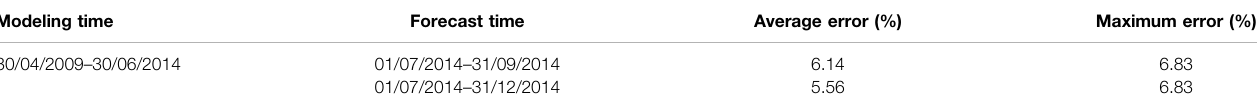
TABLE 10 | Slope stability and reliability simulation accuracy statistics. Modeling time Forecast